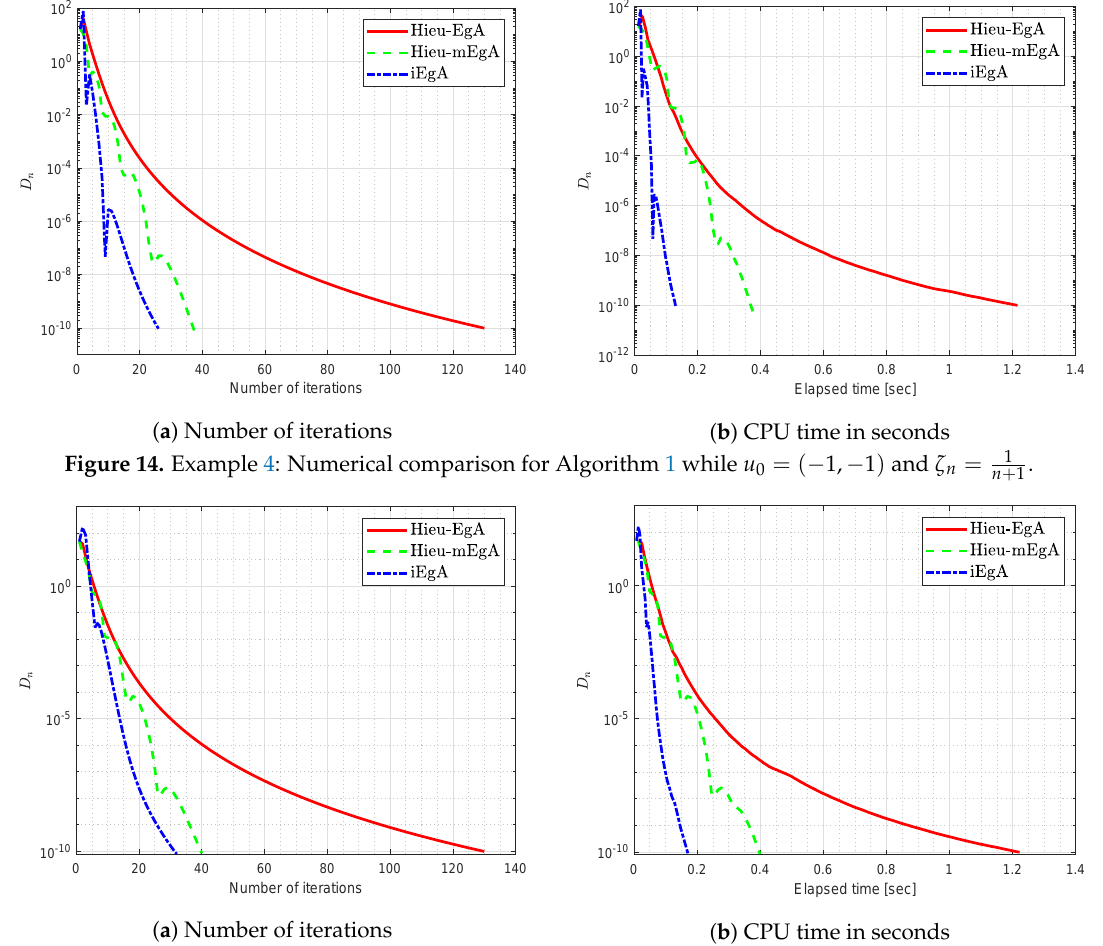
Figure 15. Example 4: Numerical comparison for Algorithm 1 while u 0 = ( − 2, − 2 ) and ζ n = 1